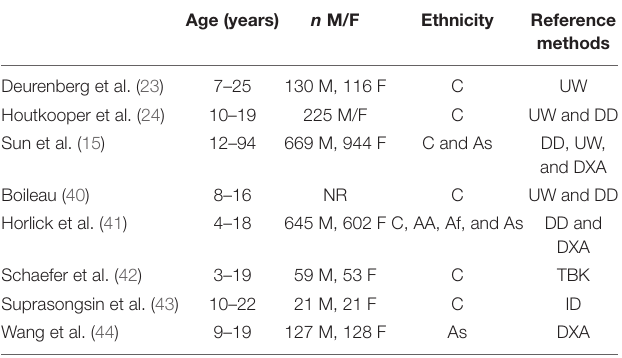
TABLE 2 | Sample characteristics of the bioelectrical impedance analysis (BIA) TABLE 3 | Cross-validation of fat-free mass predictive new equation, and equations for the prediction of fat-free mass (FFM) in adolescents. validation of other published equations. n M/F Ethnicity